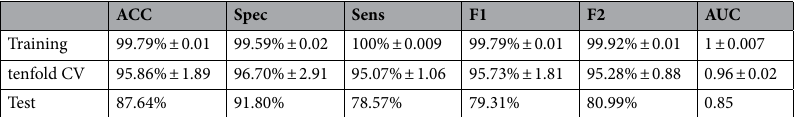
Table 1. Summary of model performance using the ensemble model EM 3-5 obtained from the combination of SVM models 3 and 5. For the training set and the tenfold cross-validation mean values and standard deviations are presented. The test set comprises the 90 left-out samples not used for training.